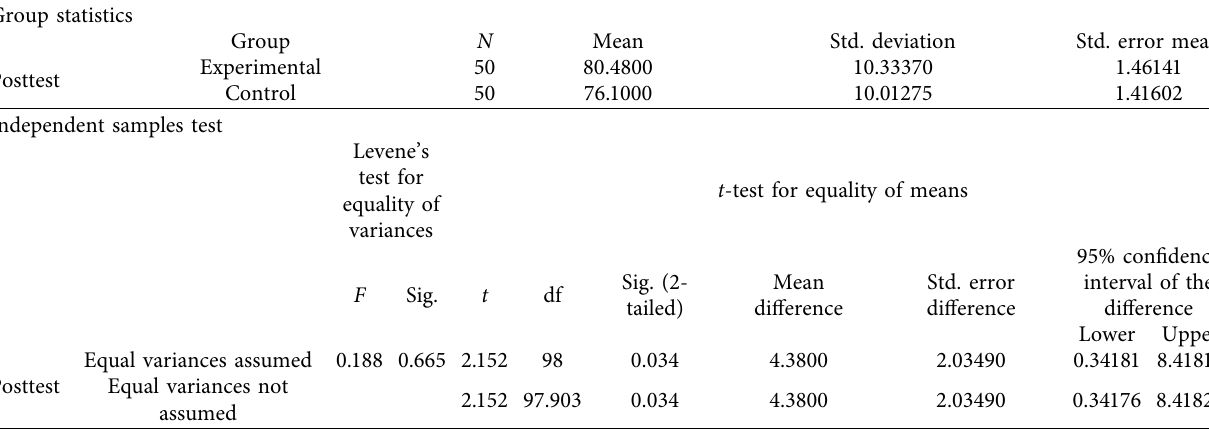
Table 3: Results of the posttest and